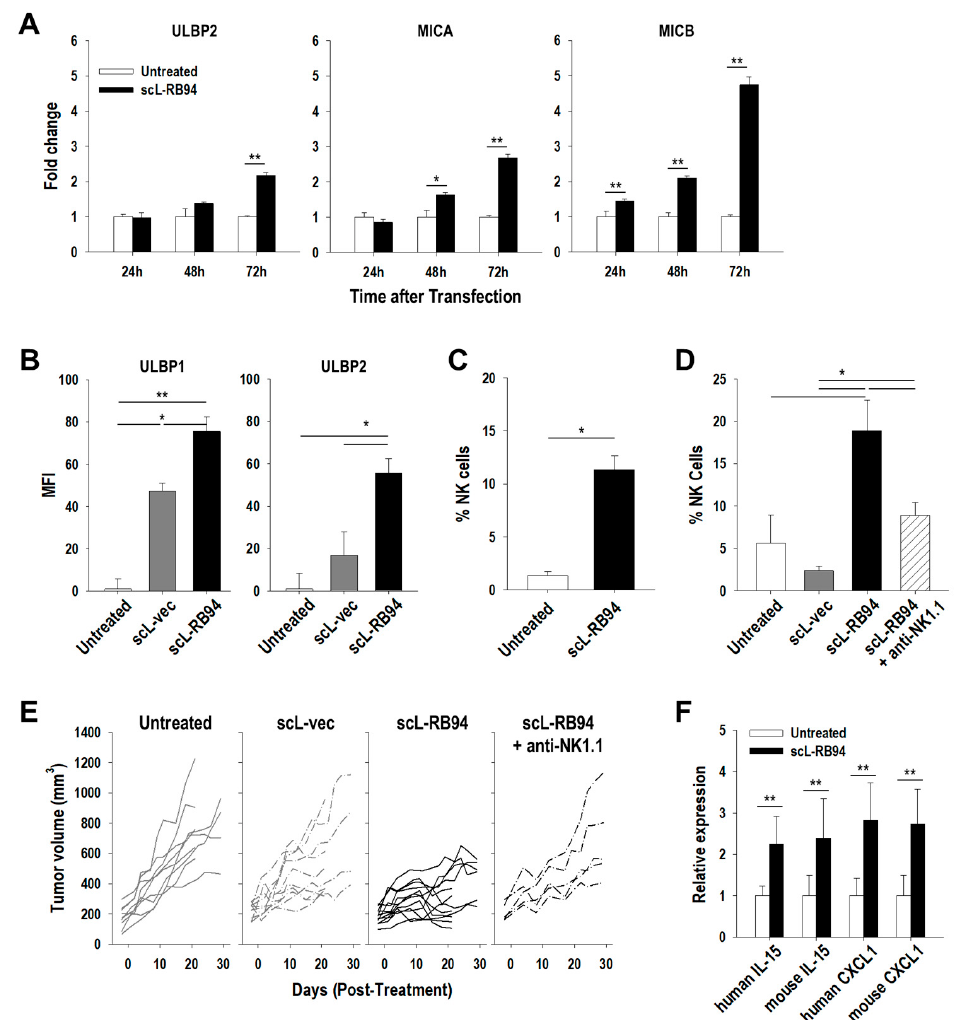
Figure 4. scL-RB94 inhibits growth of NSCLC tumors via NK cells. ( A ) Quantitative RT-PCR analysis of ligands associated with NK cell activation (ULPB2, MICA, and MICB) in H292 cells after treatment with scL-RB94 in vitro ( N = 6). * p < 0.05, ** p < 0.001, Student’s t test. Flow cytometry analysis of ( B ) ligands associated with NK cell activation (ULBP1 and ULBP2) in H358 tumors and ( C ) NK cells infiltrating H292 tumors after scL-RB94 treatment (30 µ g/injection/mouse, two injections over 3 days). NK cells were identified by gating CD45 + live cells with NK1.1 + NKp46 + . * p < 0.05, ** p < 0.001, one-way ANOVA or Student’s t test. In another procedure, athymic mice with